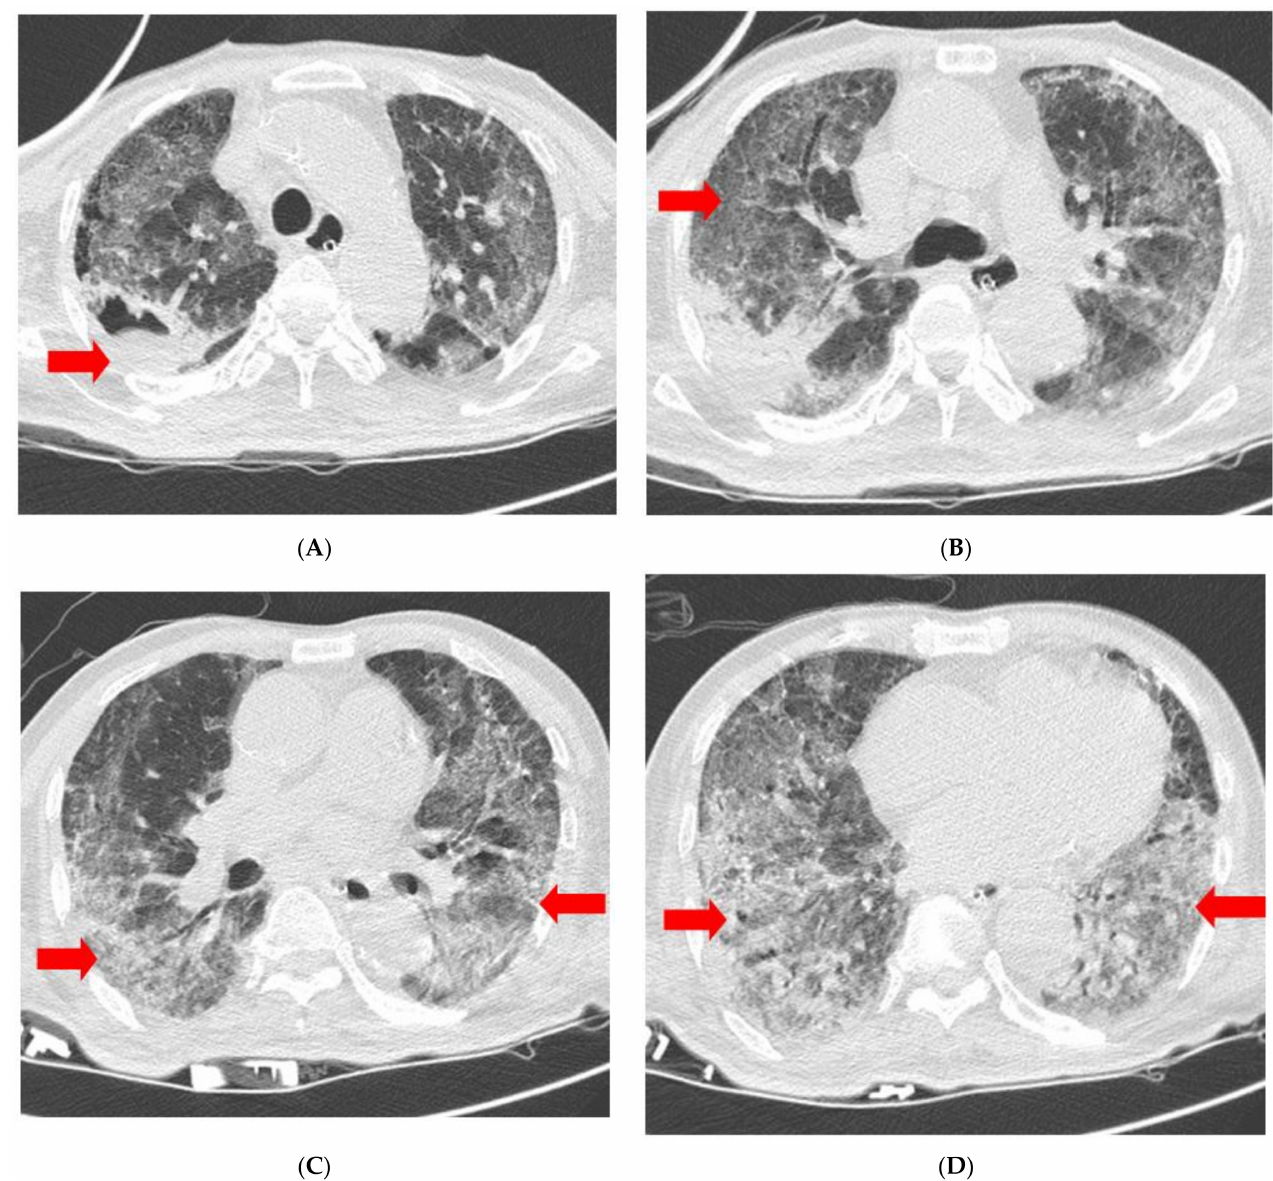
Figure 2. Chest CT scan obtained on Day 3 of MSC transplantation shows cavity ( A ) and pulmonary consolidation ( B ) at right upper lobe, and GGO at both lungs ( C , D ). Each finding is indicated by red arrowheads. CT, computed tomography; GGO, ground-glass opacity; MSC, Mesenchymal stem cell. Five days after MSC transplantation, seizures with eyeball deviation were observed and anterior cerebral artery territory infarction was suspected on CT. Aspirin was then added to prevent further infarction. This was confirmed via magnetic resonance image. Seven days after administration, the patient was mechanically ventilated at PEEP: 8 cmH 2 O and pressure-controlled mode (pressure setting: 8 cmH 2 O) with a value of FiO 2 : 0.5. PaO 2 /FiO 2 was 129.1 mmHg, and O 2 saturation was 94.4. Chest radiography showed slight regression of the GGO in both lower lung fields (Figure